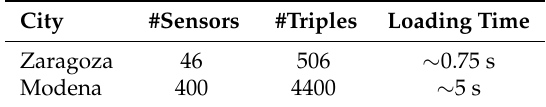
Table 1. Sensor data performance evaluation: loading